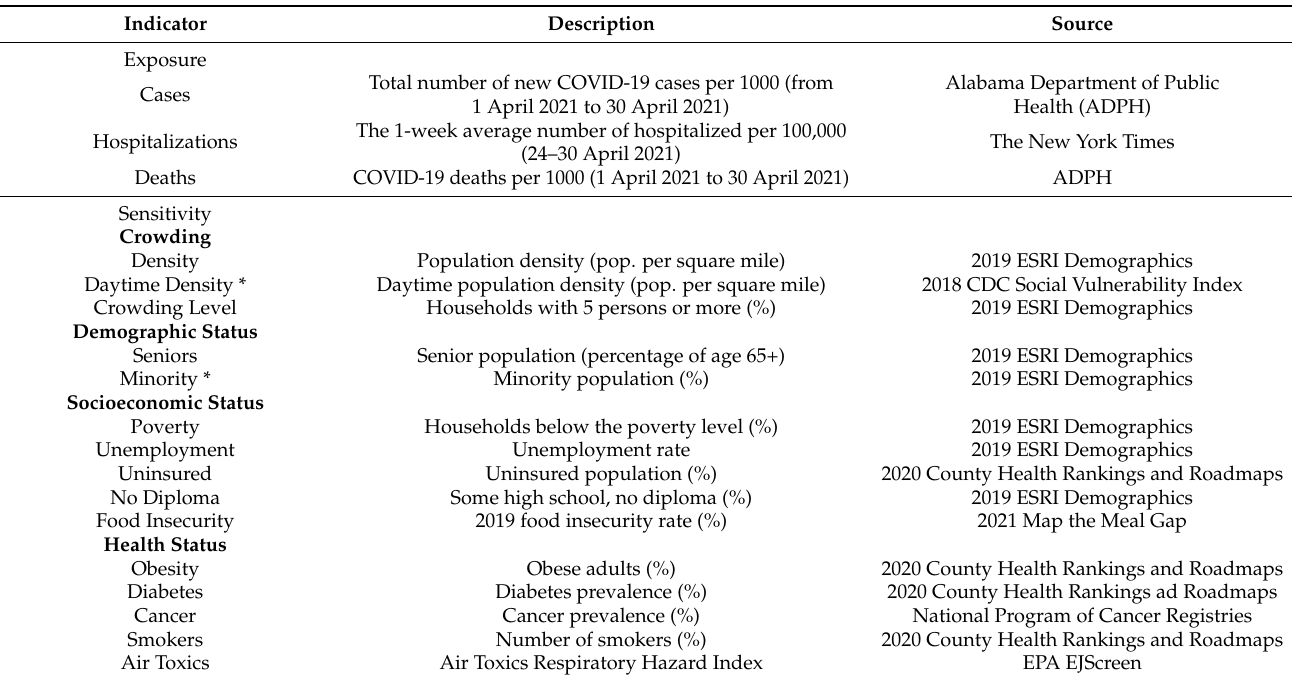
Table 1. Description of indicators for each subindex and data